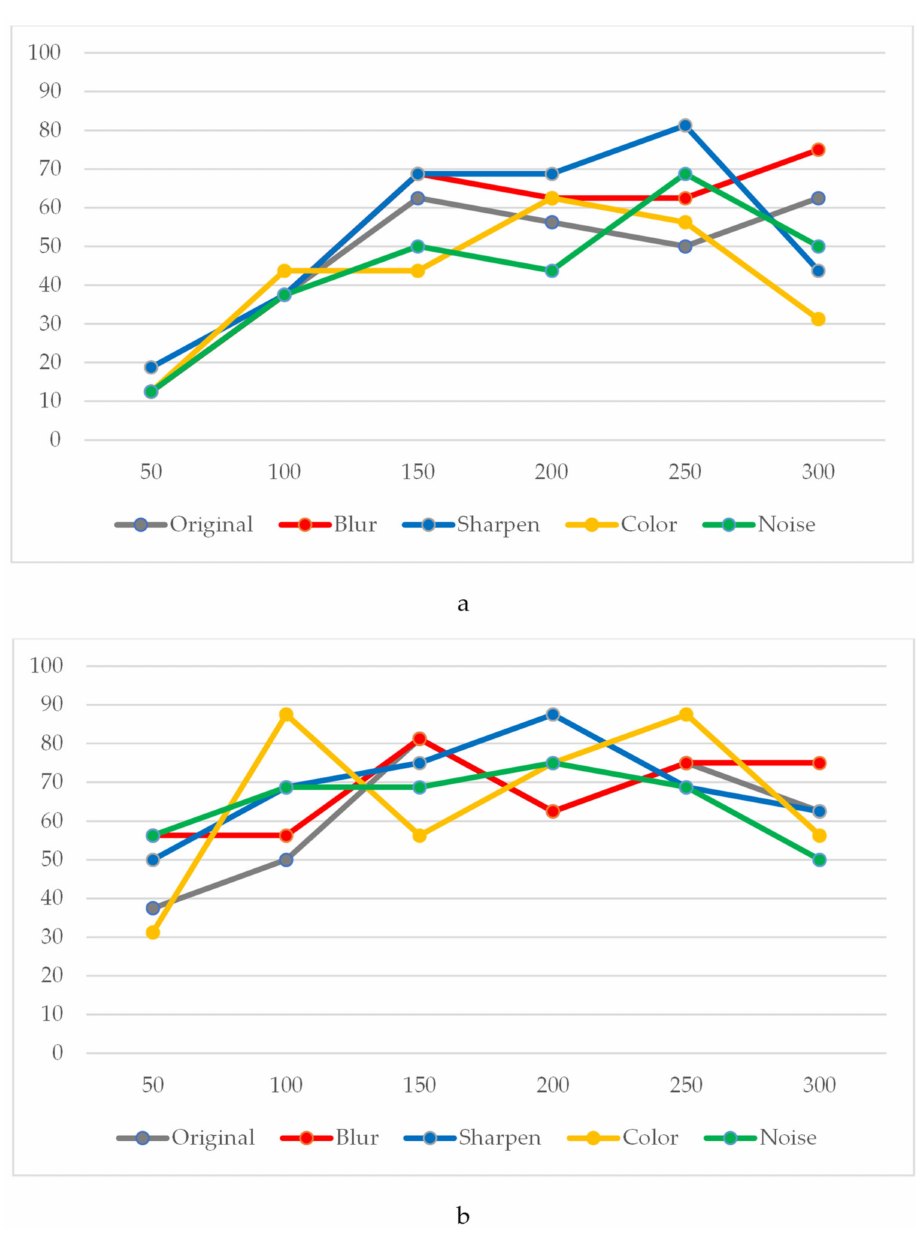
Figure 7. The learning curves of panoramic detection ( a ) and cross-sectional detection ( b ) of each trained